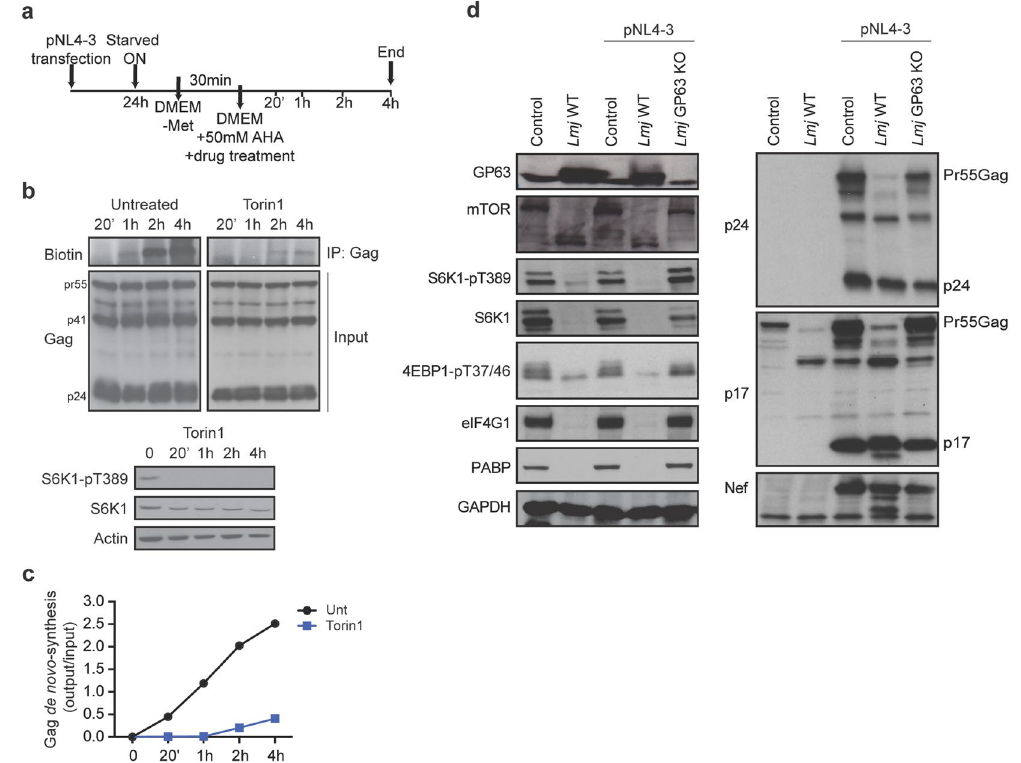
Figure 2. mTOR activity is required for optimal viral-protein synthesis. ( a ) Schematic of experimental protocol. ( b ) HeLa cells were transfected with pNL4-3, left untreated or treated with 250 nM Torin1 in medium containing AHA. At the indicated times, cell lysates were collected and Click-it chemistry was performed followed by immunoprecipitation with rabbit anti-p24 antibody. Membranes were probed with the indicated antibodies. ( c ) Densitometry quantification of de novo synthesized, biotinylated Gag from panel b was determined by ImageJ analysis. For each time point, the values presented in the graph are normalized against the total amount of Gag in the cell lysate (refer to Supplementary Fig. 1 for total protein synthesis). Full-length blots are shown in Supplementary Fig. 5. ( d ) HeLa cells were transfected with either pcDNA3.1 or pNL4-3 and infected with L. major (lmj) WT or GP63 KO. Cell lysates were subjected to SDS-PAGE, immunoblotted and probed with the indicated antibodies against host (left panels) and viral (right panels)